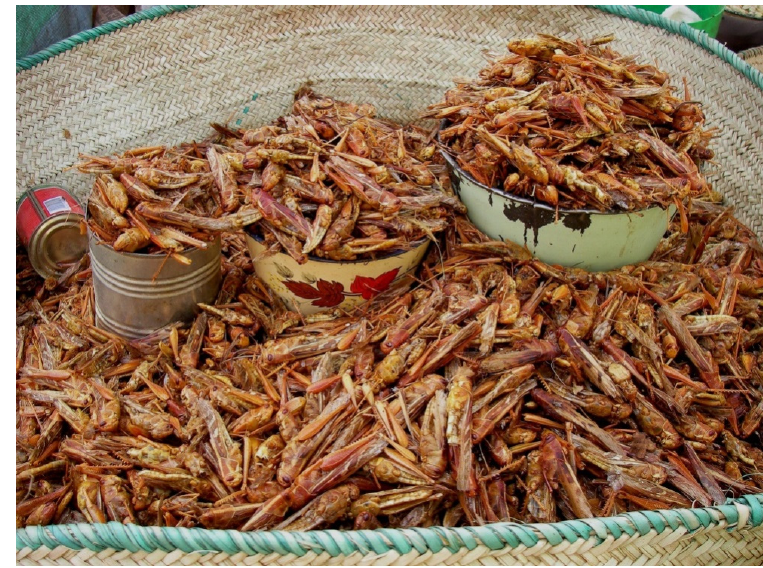
Figure 1. Fried locusts sold on a Western African market (image by S. Tchibozo).